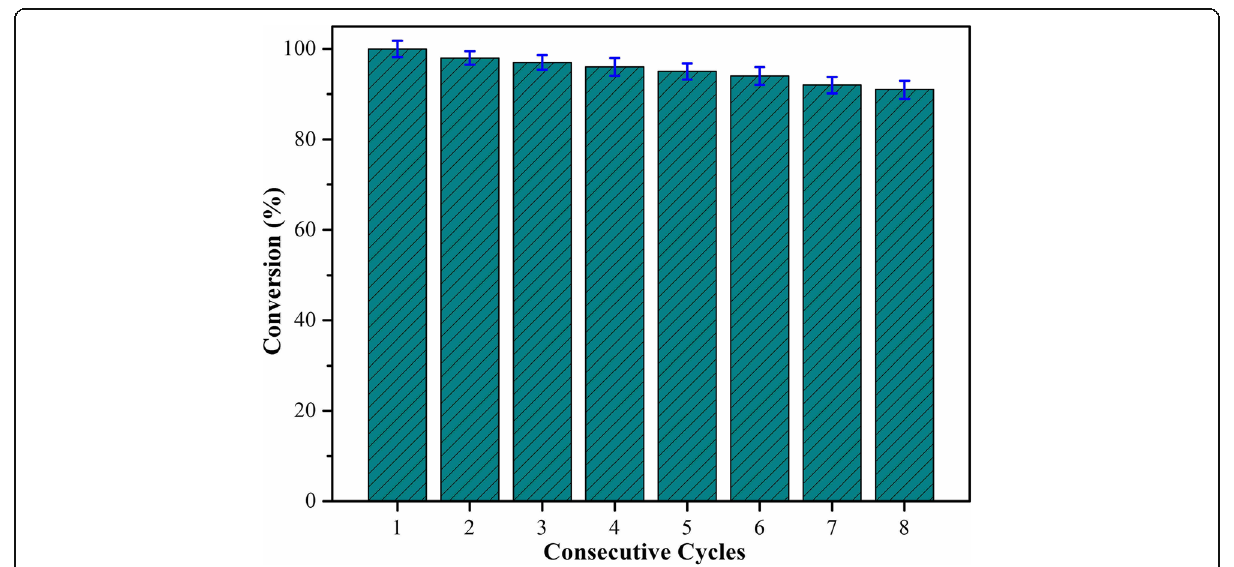
Fig. 6 Reusability test of CNT-Cu-30-1 nanocomposite as a catalyst for the reduction of 4-nitrophenol with NaBH 4